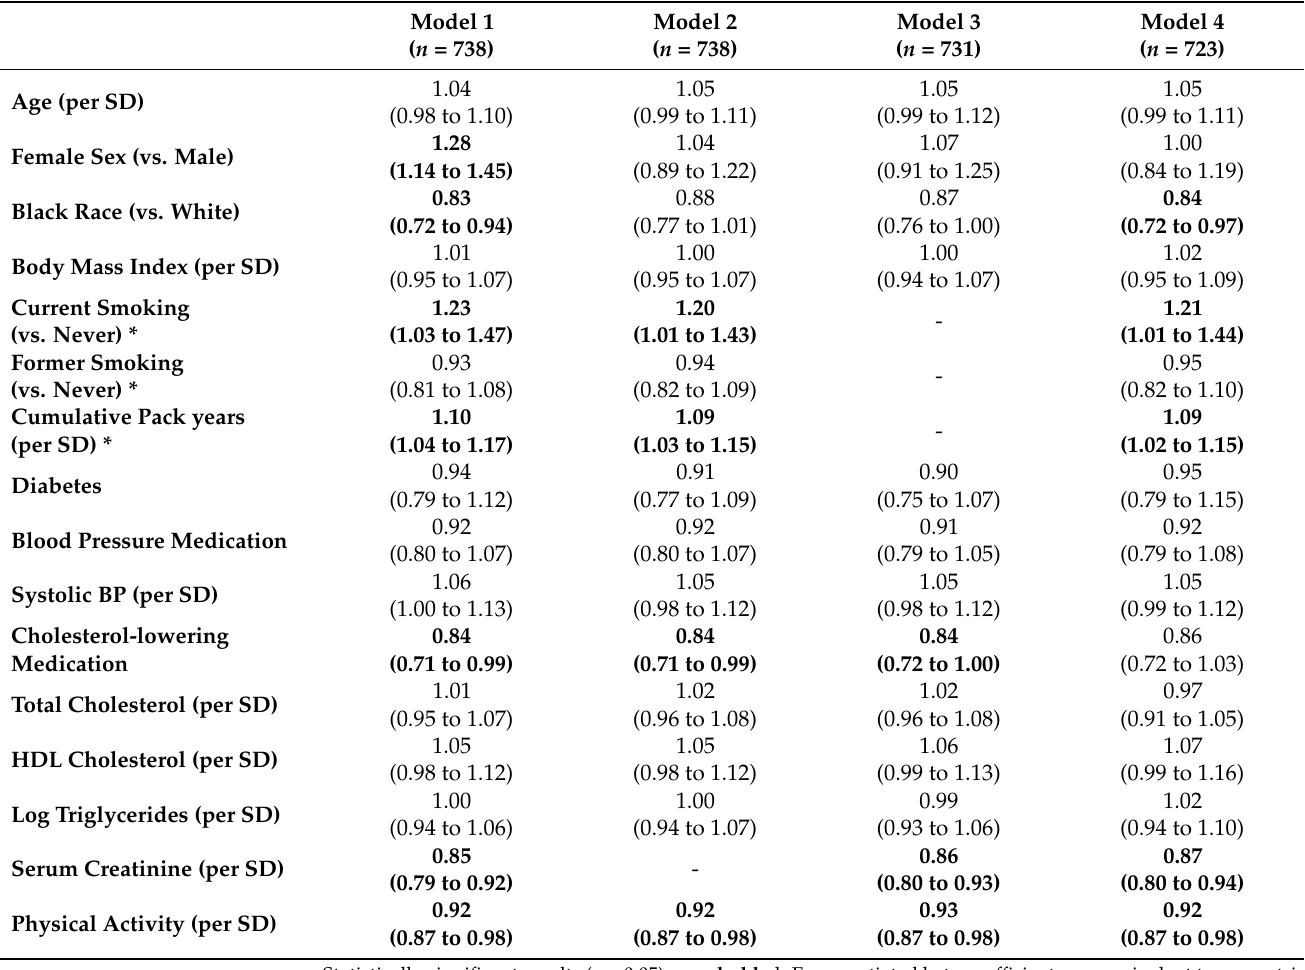
Table 2. Adjusted associations between IsoP vs. cardiovascular risk